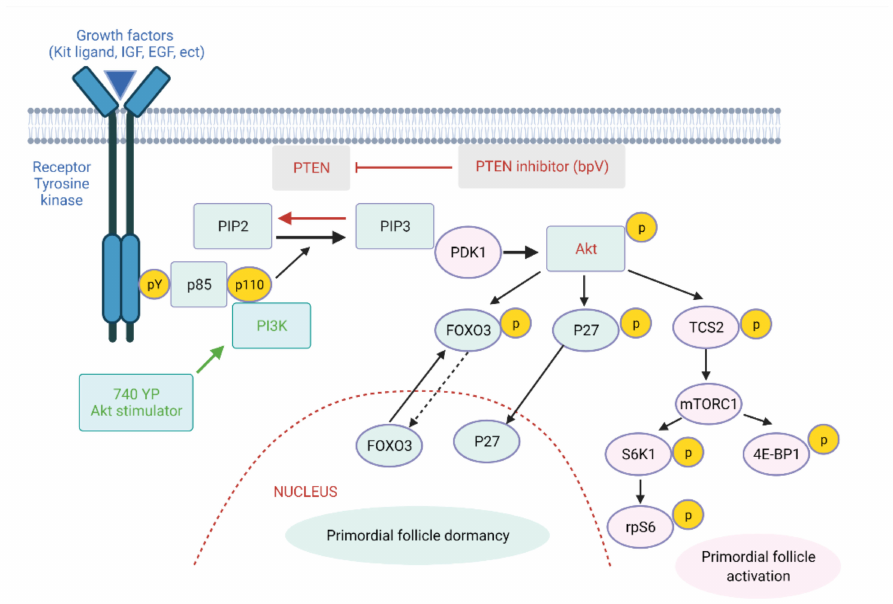
Figure 2. The phosphoinositide 3-kinase (PI3K)/Akt/ forkhead box O3 (FOXO3) pathway in oocytes regulates PF activation. Upon growth factors binding to tyrosine kinase receptors (Kit ligand, insulin-like growth factor (IGF), epidermal growth factor (EGF), etc.), the autophosphorylation of intracellular regions of these receptors takes place. Activated receptors then stimulate PI3K activity, leading to increases in phosphatidylinositol-3,4,5-triphosphate (PIP3) levels and phosphatidylinositol- dependent kinase 1 (PDK1) as well as Akt stimulation. Activated Akt then migrates to the cell nucleus and suppresses FOXO3 actions to promote primordial follicle growth [8,10]. Akt also promotes the phosphorylation of tuberous sclerosis 2 (TCS2), which enhances mammalian target of rapamycin complex (mTORC1) activation. S6 kinase (S6K), ribosomal protein S6 (rpS6) and eukaryotic translation initiation factor 4E binding protein 1 (4E-BP1) are the downstream substrates of mTORC1 which promote the translation of related mRNAs following by cell growth and